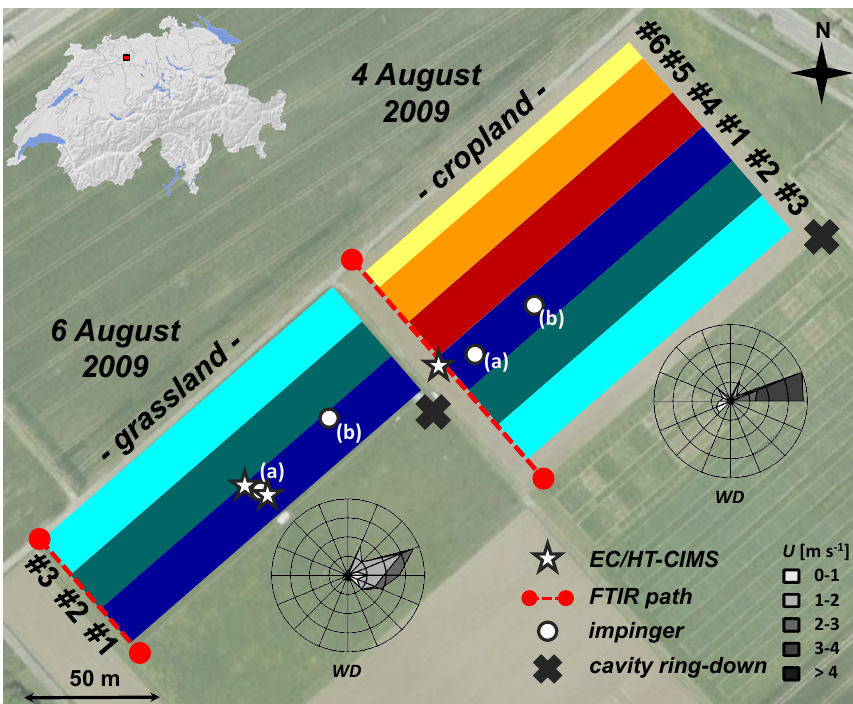
Fig. 1. Application of liquid cattle slurry by sequential spreading of six tanks (tracks #1...#6 on the cropland on 4 August 2009) and three tanks (tracks #1...#3 on the grassland on 6 August 2009), respectively, including wind direction (WD) and wind speed ( U ) from the start of slurry application until the end of the respective day; locations of measurement systems are displayed, (a) and (b) denote different impinger positions, EC/HT-CIMS position on 6 August on #1 only temporary until #2 was dispensed; satellite image: ©Google Inc., 2010.